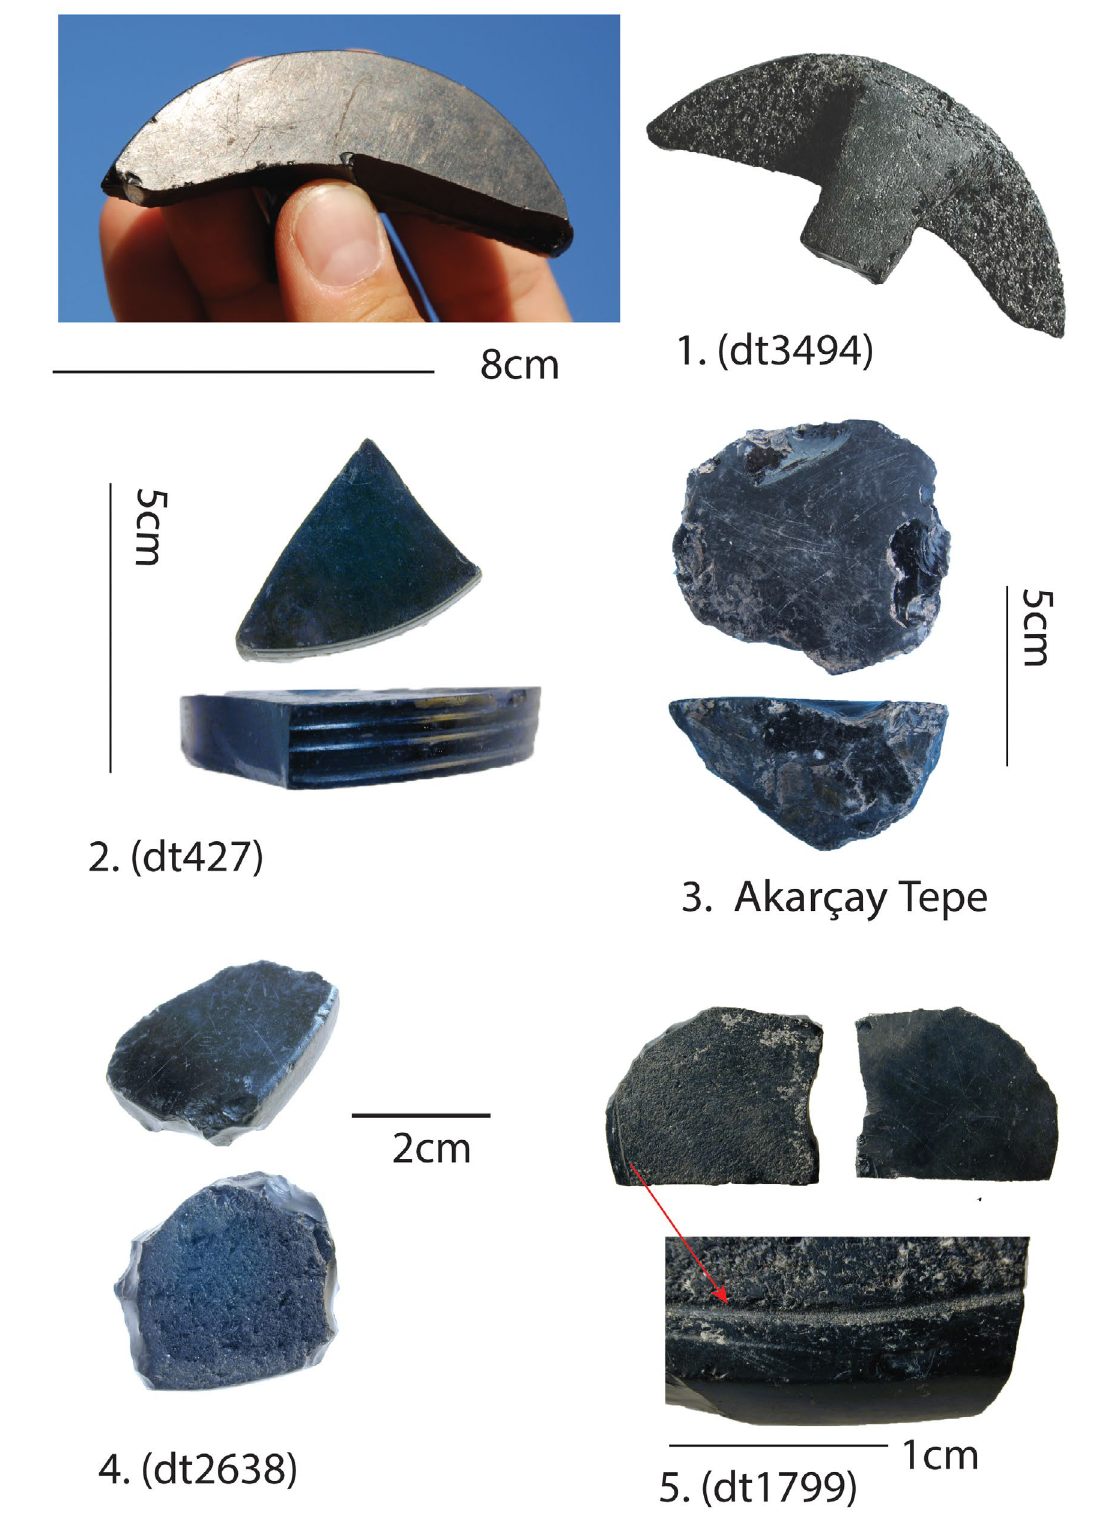
Figure 7. Mirrors and Discs. No. 1a and b fragments of a mirror with a strap handle from Domuztepe. Note the different levels of finish on the back. (photograph No. 1a courtesy of Laurence Astruc and Roberto Vargiolu); No. 2 a disc polished on both surfaces and with three grooves inscribed around the circumference; No. 3 possible mirror on a chunk of obsidian Akarçay Tepe, PPN to PN transitional levels (photograph courtesy of Ferran Borrell), nos. 4 and sub-circular 5 mirror fragments from Domuztepe, with one polished surface and the other pecked or abraded, and the sides smoothed. Note the groove on the upper surface of No. 5. (Domuztepe photographs courtesy of Stuart